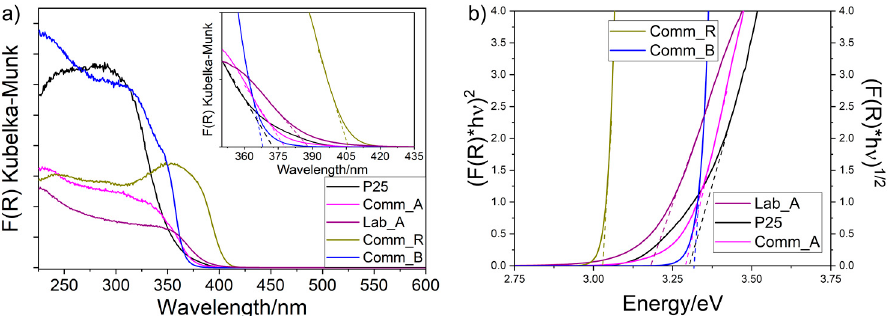
Figure 5. ( a ) DR UV-Vis spectra of the studied powders, where dotted lines allow determination of the bandgap energy from the onset of absorption. ( b ) The Corresponding Tauc’s plot, as obtained by considering Comm_B and Comm_R as direct semiconductors, and Comm_A, Lab_A, and P25 as indirect semiconductors, and where dotted lines allow determination of the bandgap energy from the plot. Table 2. Results of XPS analysis concerning the surface chemical composition and the curve-fitting of the Ti 2p and O1s lines; band-gap values, as obtained from DR-UV-Vis spectra by applying the Tauc’s plot method and by extrapolation of the absorption onset; VB value as obtained by XPS analysis and calculated CB energy.